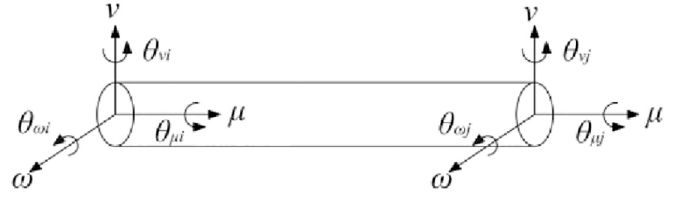
Fig 2. Space unit composed of joint